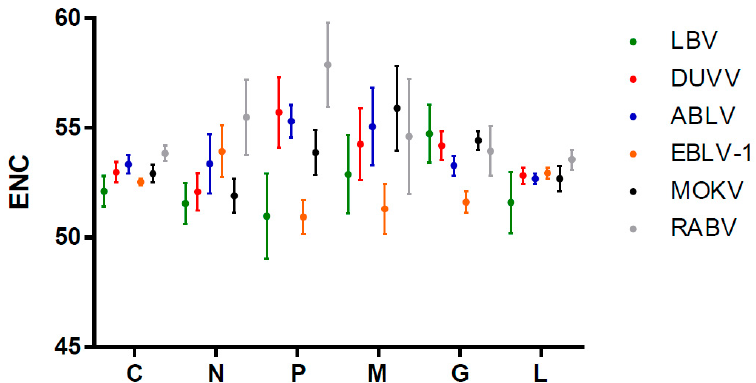
Figure 1. Species-specific comparative analysis of ENC (effective number of codons) values of each lyssavirus coding sequences. C means complete genome. Green, red, blue, orange, black and grey represent LBV (Lagos bat virus), DUVV (Duvenhage virus), ABLV (Australian bat lyssavirus), EBLV-1 (European bat lyssavirus 1), MOKV (Mokola virus) and RABV (rabies virus), respectively.